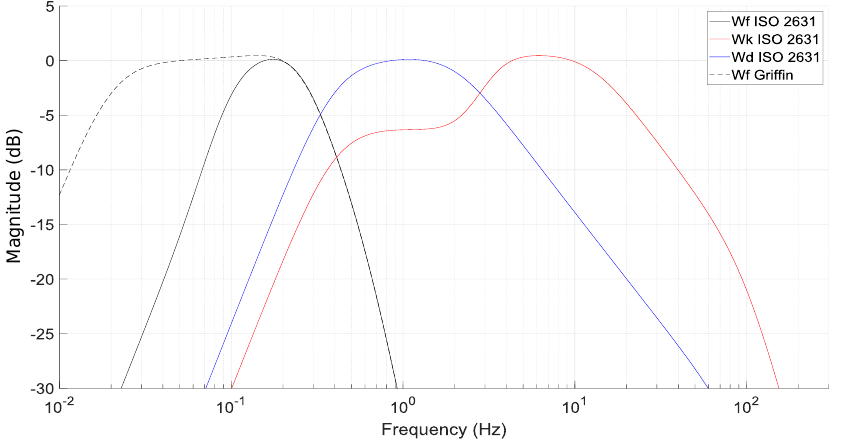
Figure 1. Filters proposed by ISO 2631 [37] and Griffin in [35,39–41].